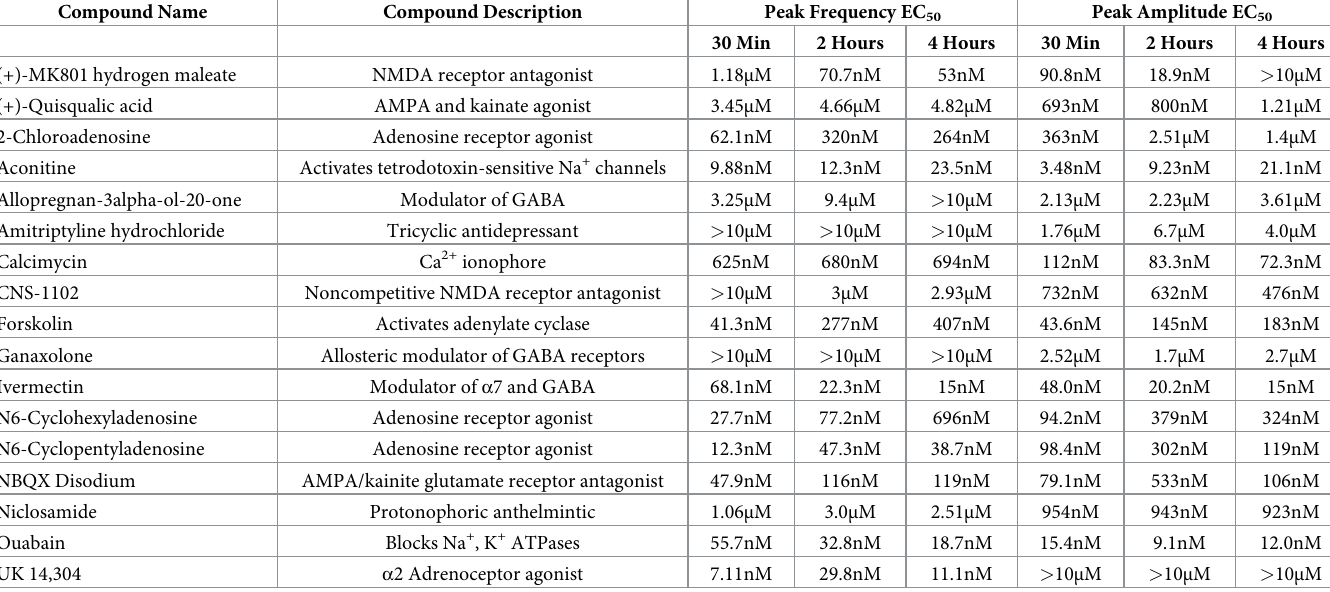
Table 3. EC 50 values for each of the 17 compounds tested in the concentration response experiment at 30 minutes, 2 hours, and 4 hours after compound